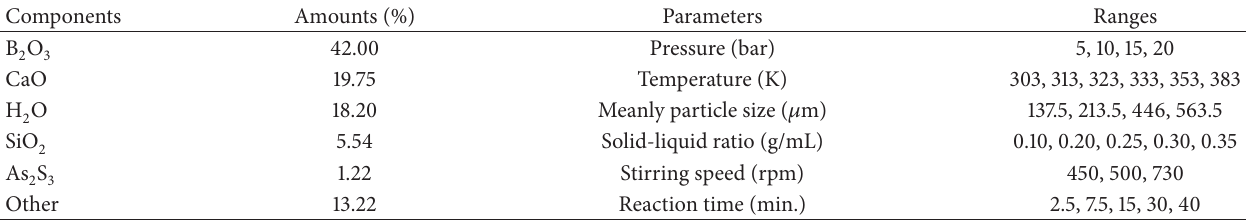
Table 2: The chemical characteristic of colemanite mineral and ranges of